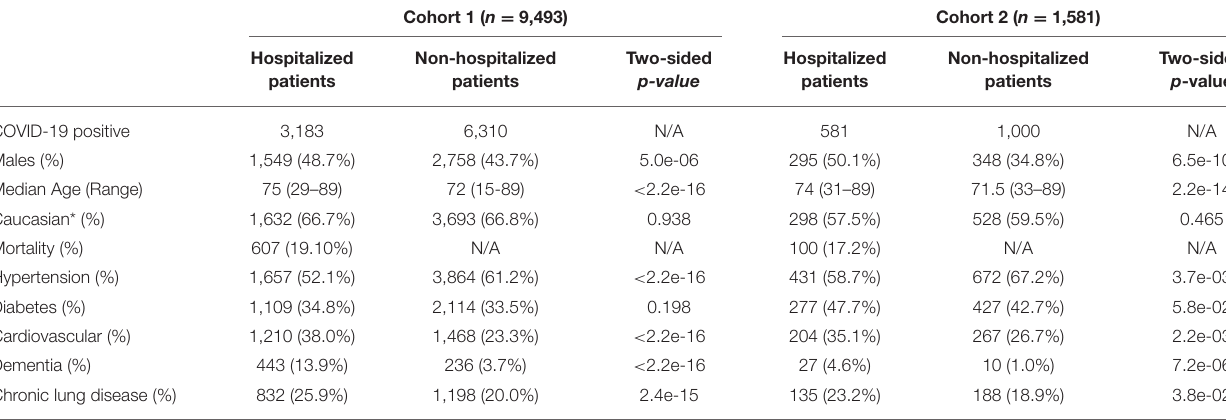
TABLE 1 | Cohort characteristics for the hospitalization risk